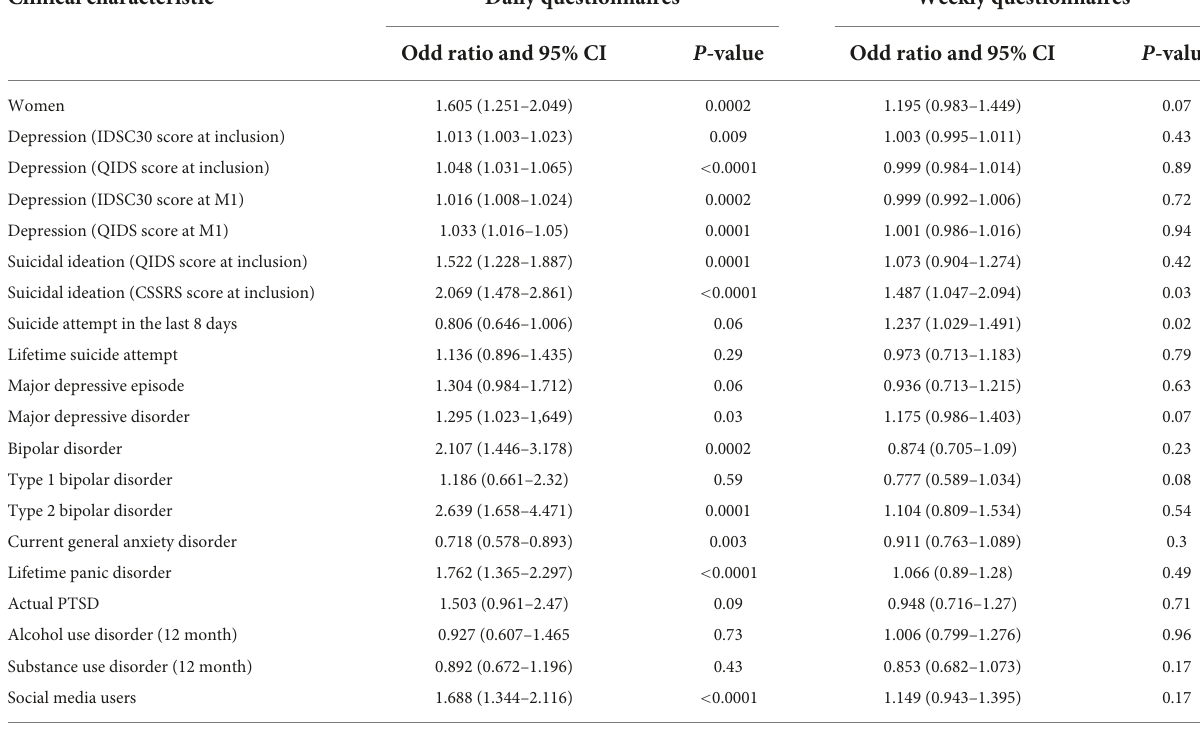
TABLE 2 Clinical characteristics and completion rate of the daily and weekly questionnaires.